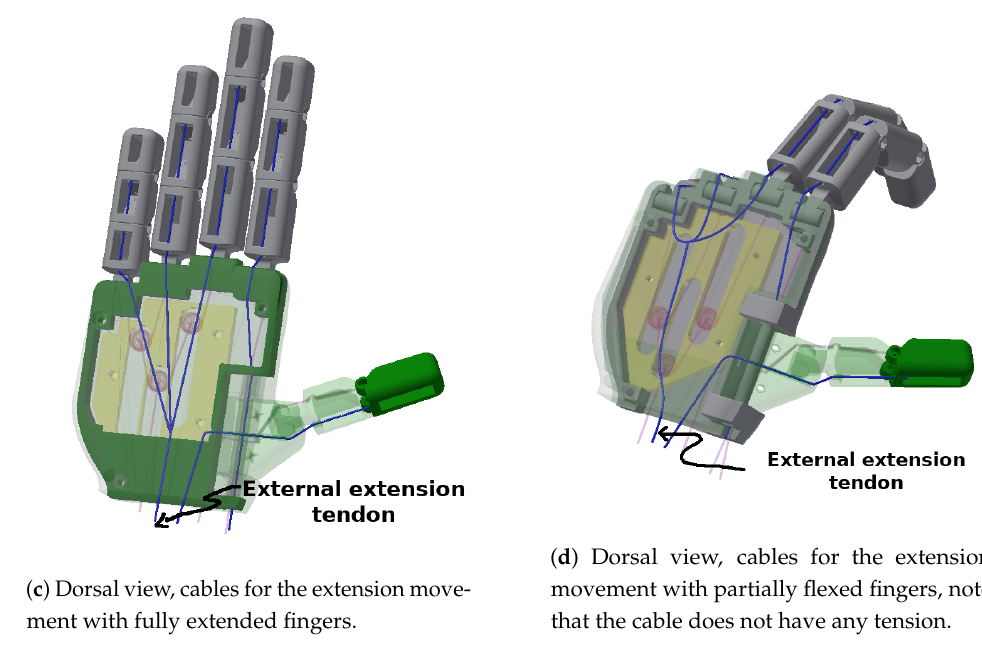
Figure 8. Diagram of the internal tendons and pulleys during flexion and extension movements of the middle, annular and little